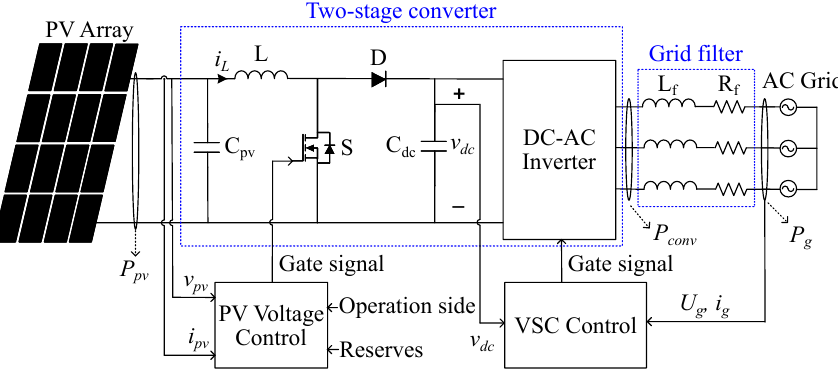
Figure 7. Topology of grid-connected PV